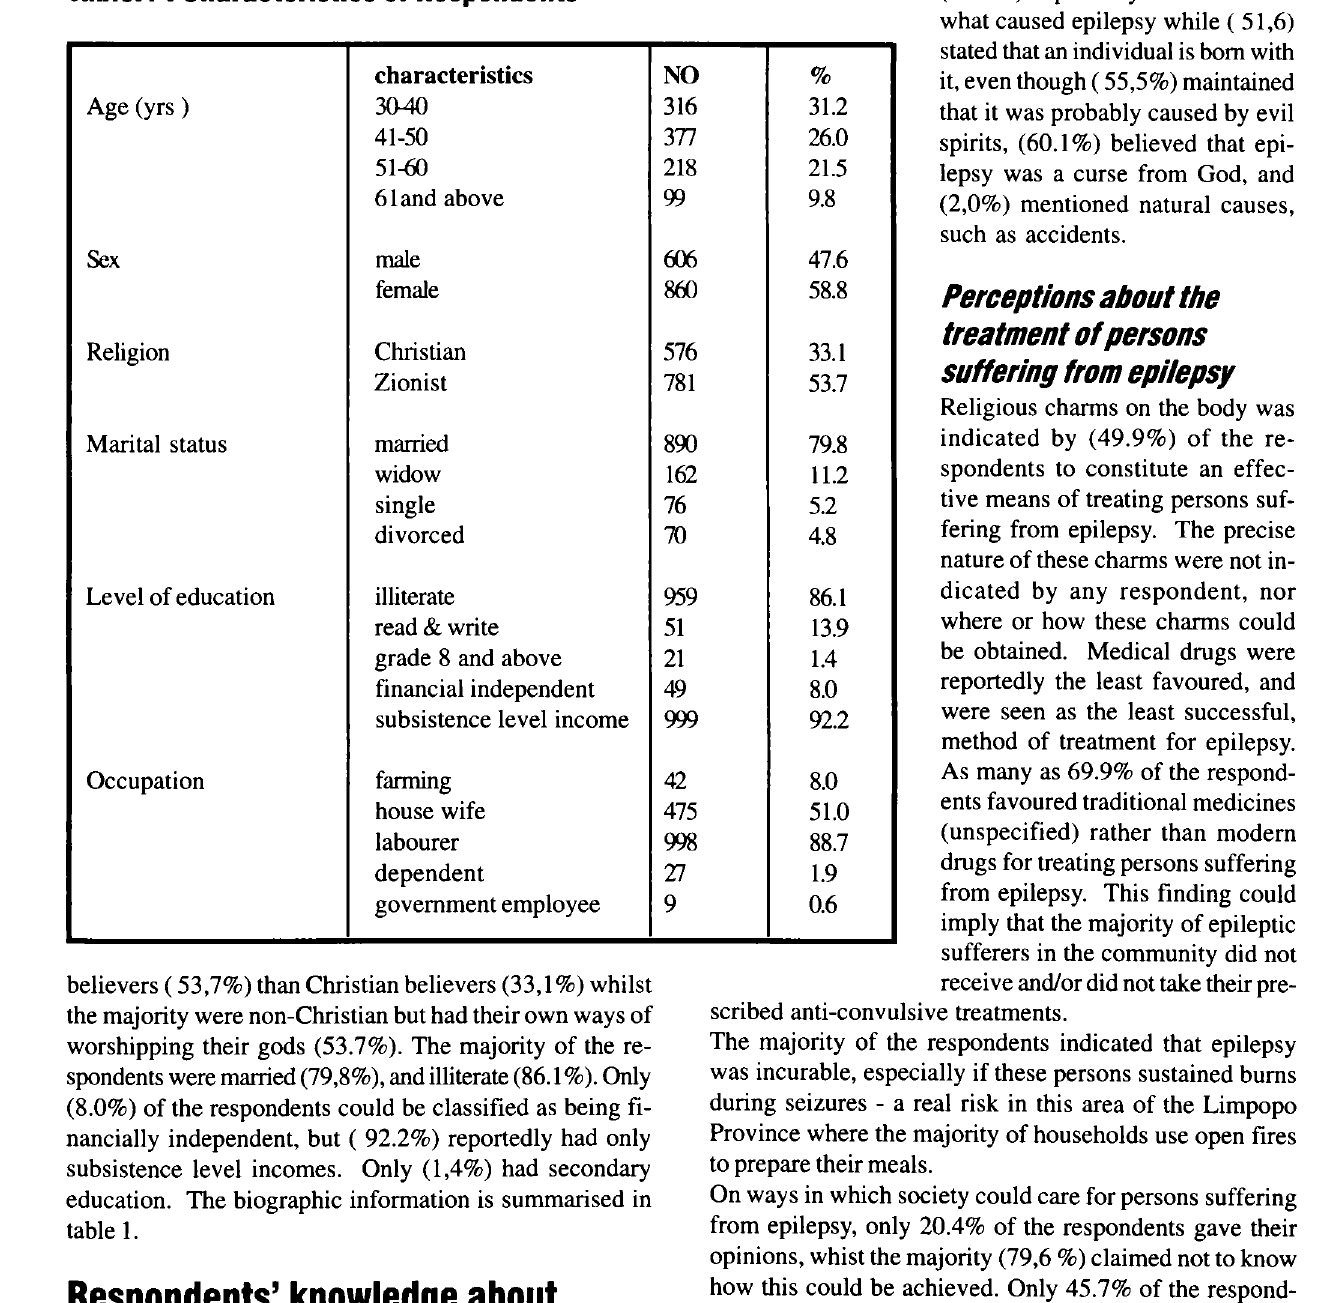
Table.1 : Characteristics of